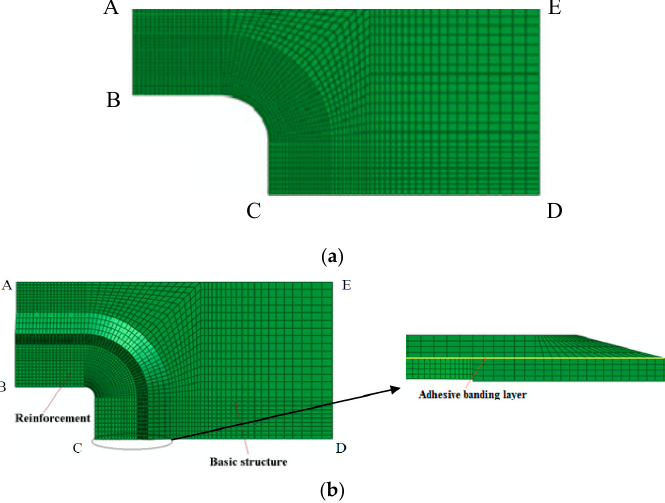
Figure 2. Experimental Images: ( a ) Distribution of strain gauge (All length units is mm); ( b ) Experimental Configuration.